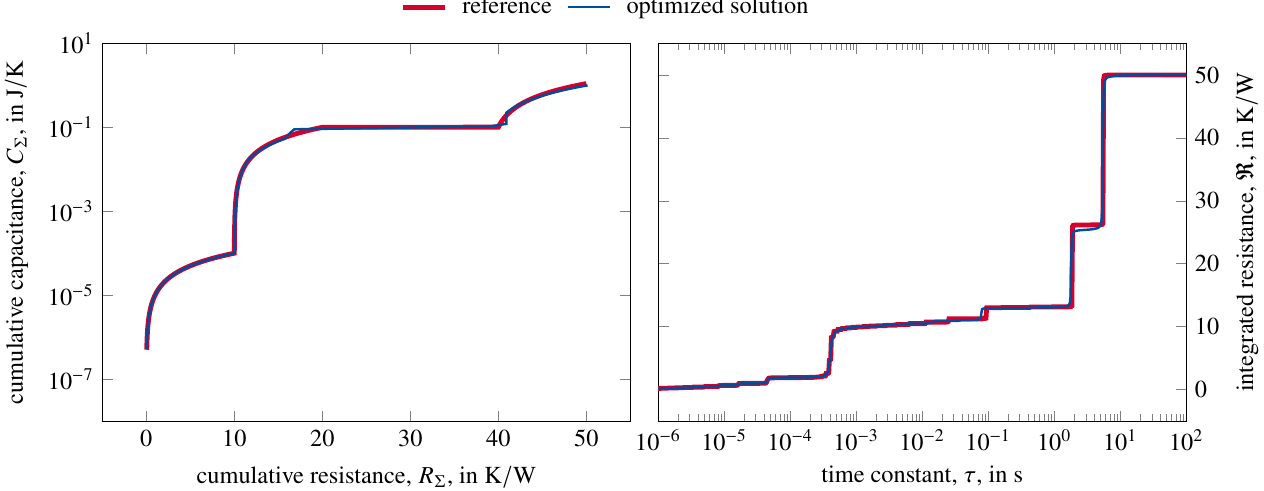
Figure 4. Result for the optimization-based network identification using the Powell solver with ten sections. The initial values are as shown in Figure 1. The measures of accuracy are m R = 3.52 and m S = 2.46. For the calculation, structure 2 is used as an example (see Table